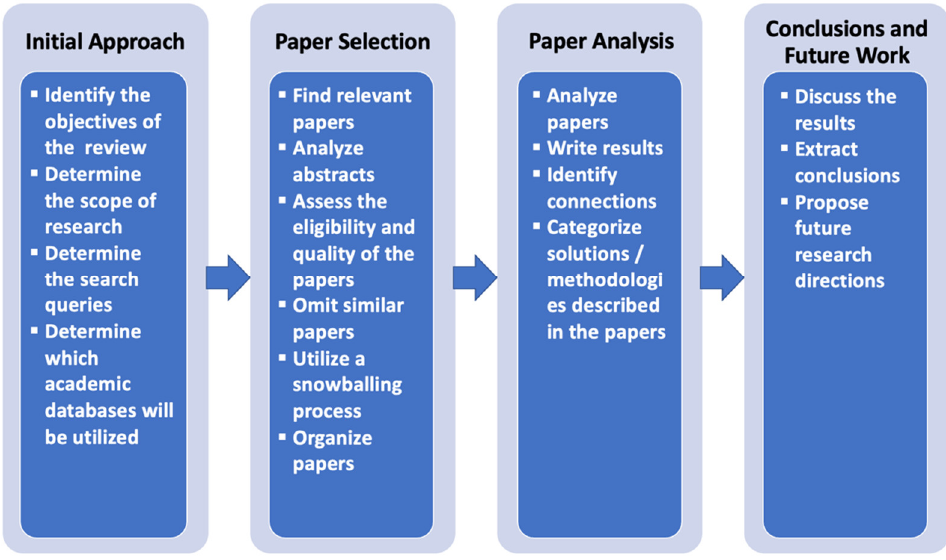
Figure 1. Stages of the present literature review.